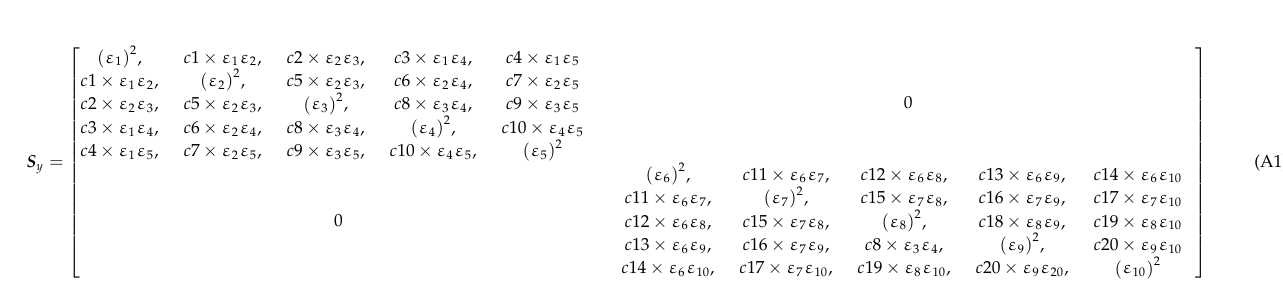
Combined with statistical data, c1~c20 refer to the measurement correlation coefficients between different observation angles. ε 1 – ε 10 correspond to the intensity and polarization measurement errors between the five observation angles for each multi-viewing